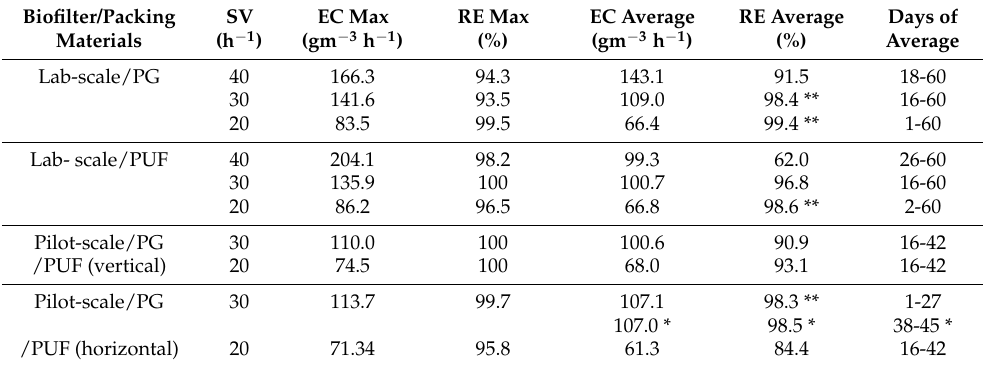
Table 2. Comparison of the H 2 S elimination capacity in the laboratory- and pilot-scale biofilters packed with immobilized P. versutus CM1 cells on PG and PUF.